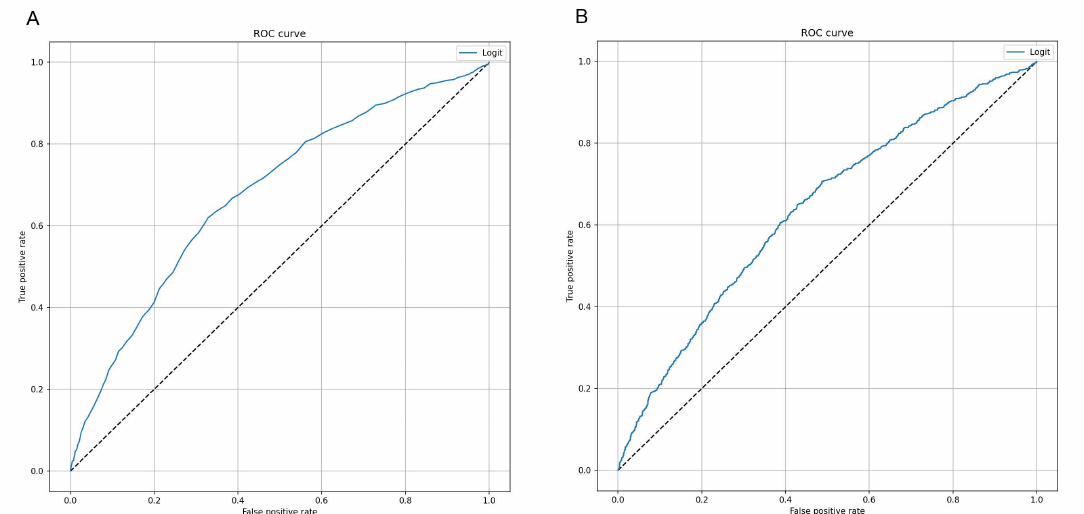
Figure 1. Receiver Operating Characteristic (ROC) curves of logistic regression models to predict 7-day mortality. ( A ) This curve shows the predictive performance of a logistic regression model using Simplified Acute Physiology Score (SAPS II) alone. ( B ) This curve shows the predictive performance of a logistic regression model including sex, patient’s origin, type of intensive care unit (ICU) admission, non-surgical treatment for acute coronary disease, surgical intervention, presence of invasive devices at ICU admission, trauma, impaired immunity, antibiotic therapy in 48 h before or after ICU admission.